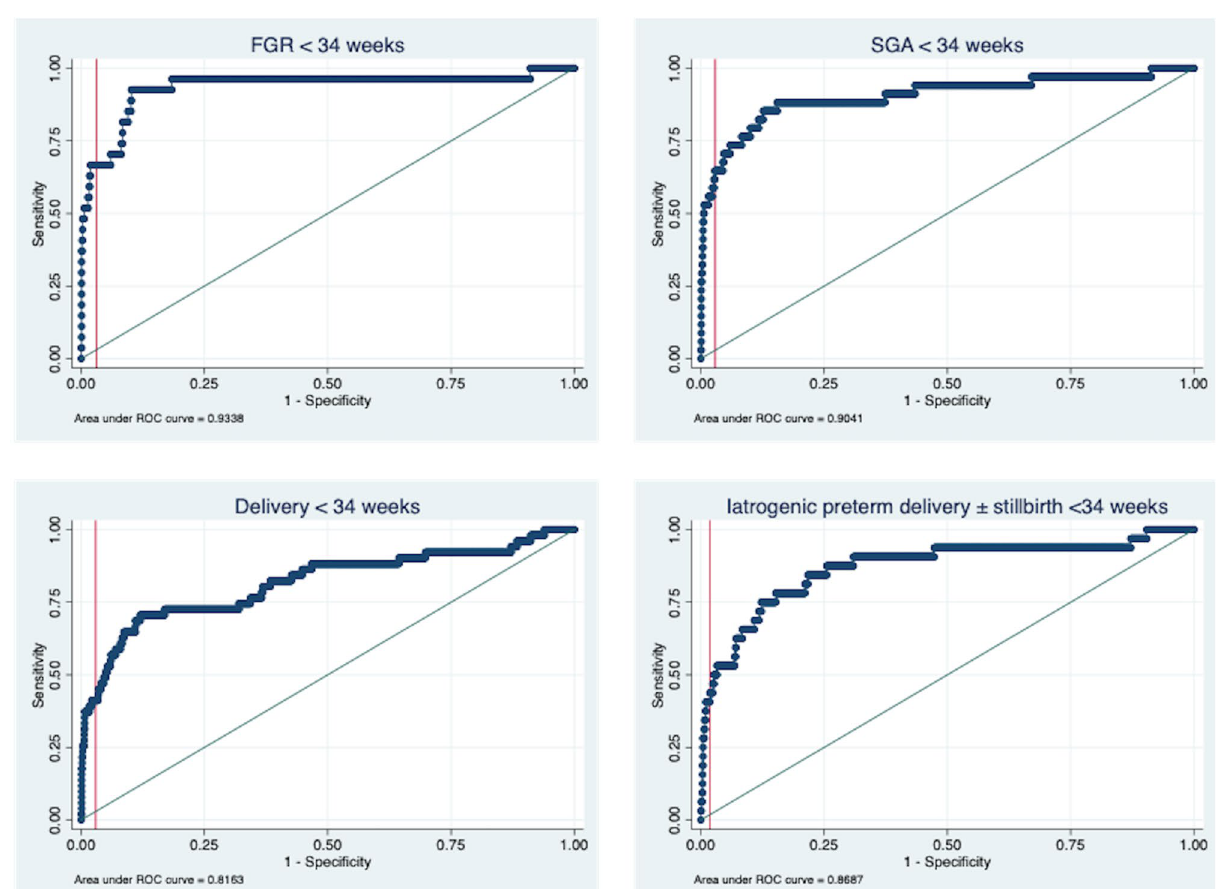
Figure 3. Receiver operating characteristic curve (ROC) analysis of log (mean uterine artery PI) and log (customised EFW centile) to predict adverse pregnancy outcomes < 34 weeks gestation. The vertical lines indicate the threshold for a positive